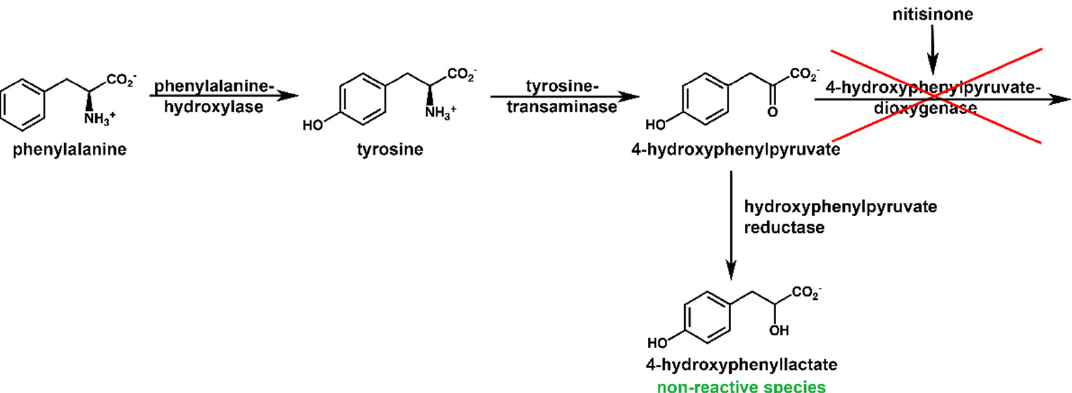
Figure 6. Inhibition of 4-hydroxyphenylpyruvate-dioxygenase by nitisinone makes two new metabolites detectable in AKU urine, the 4-hydroxyphenylpyruvate and its reduction product 4-hydroxyphenyllactate. The latter has been proved by NMR to be a non-reactive species when exposed to alkali.